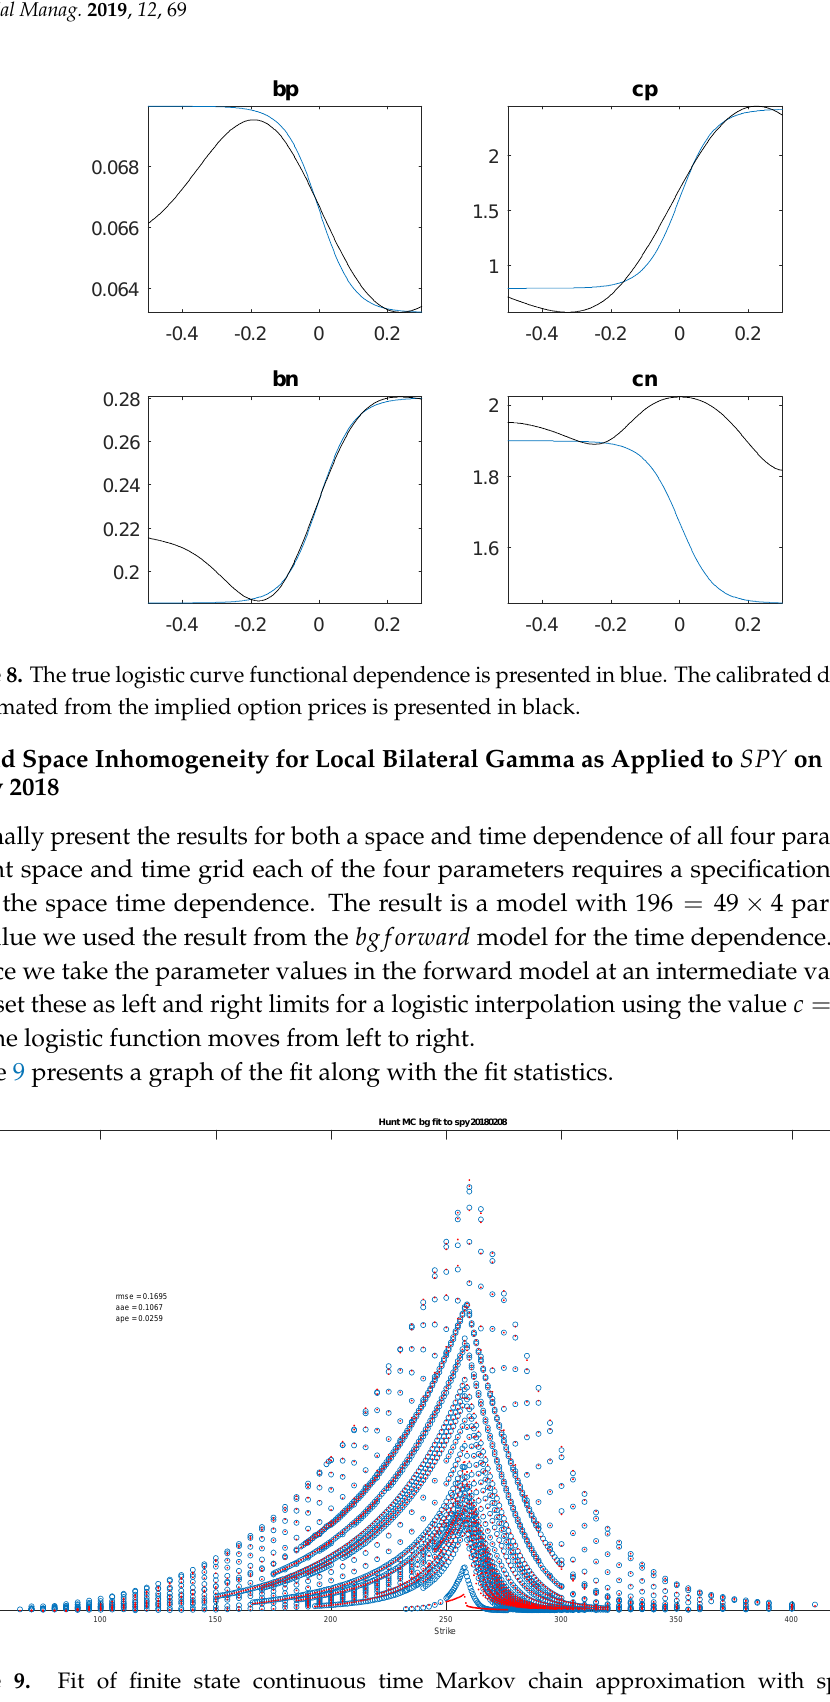
Figure 9. Fit of finite state continuous time Markov chain approximation with spatial and temporal inhomogeneity.